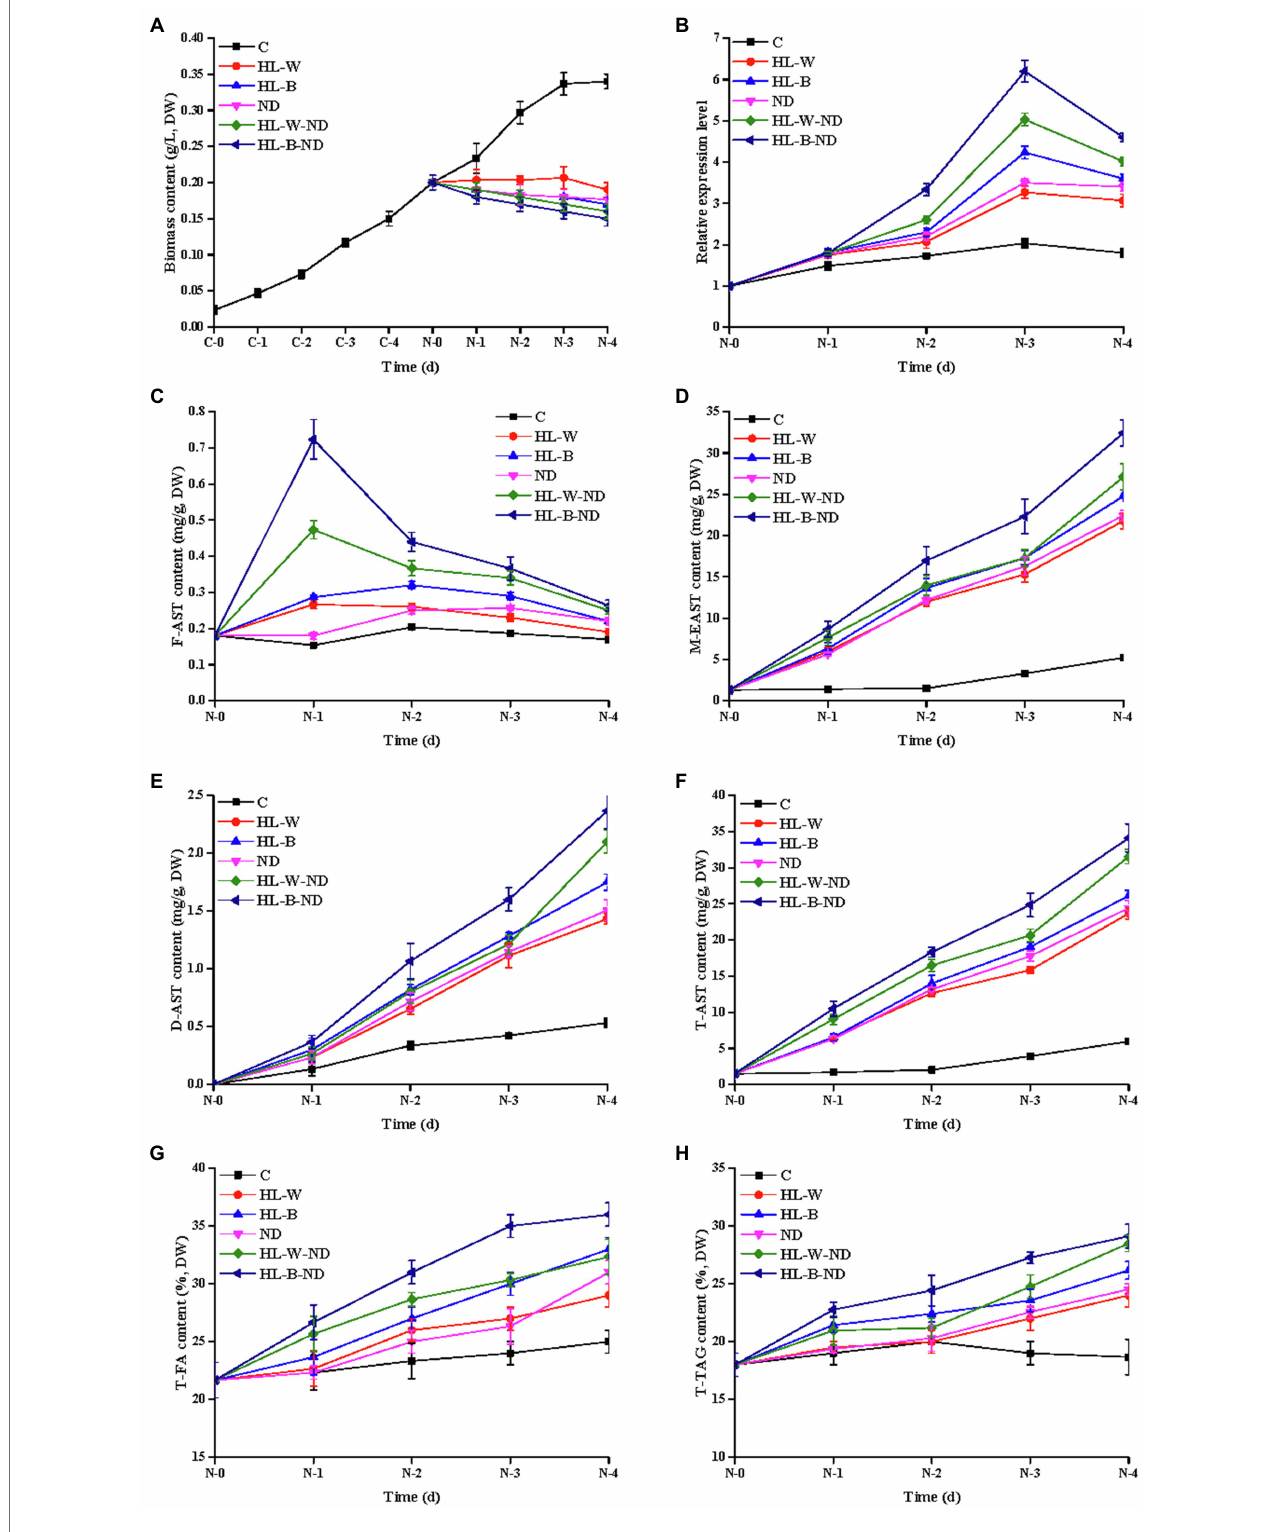
FIGURE 1 | Analysis of algal growth, transcription expression level, AST, FA, and TAG contents under HL-W, HL-B, ND, HL-W-ND, and HL-B-ND conditions after 1, 2, 3, and 4 days. (A) Algal growth of H. pluvialis. (B) The transcriptional expression levels of HpDGAT1 . (C) F-AST content. (D) M-EAST content. (E) D-EAST content. (F) T-AST content. (G) T-FA content. (H) T-TAG content. Data are means ± SE for three biological